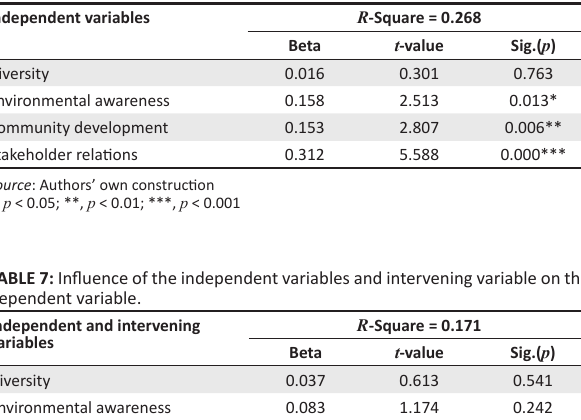
TABLE 6: Influence of the independent variables on the intervening variable Independent variables R -Square =